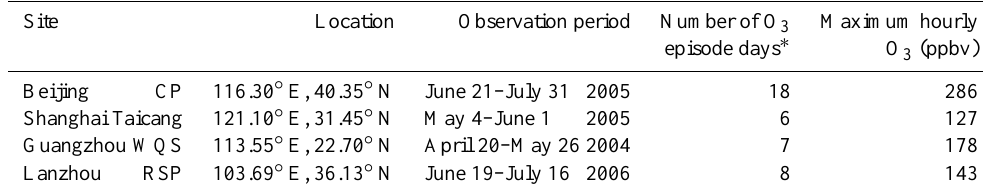
Table 1. Overview of ozone pollution conditions in four Chinese cities.